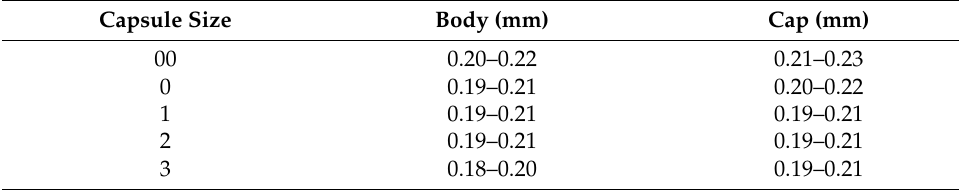
Table 4. Thickness specification of hard gelatine